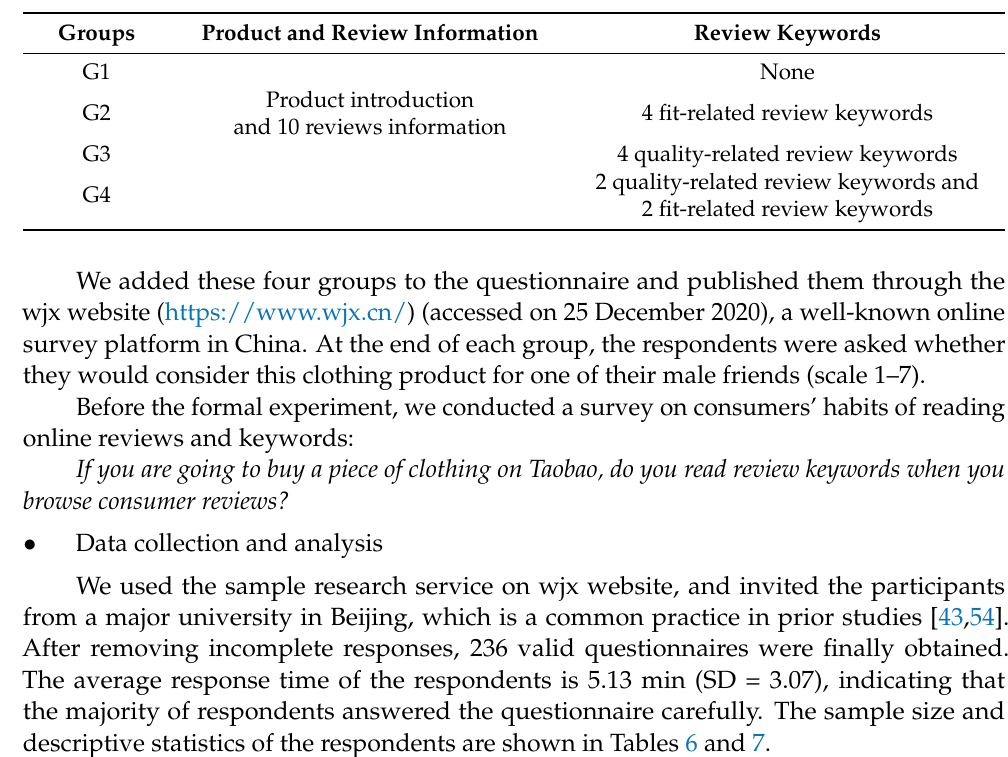
Table 5. Four groups of experimental design.